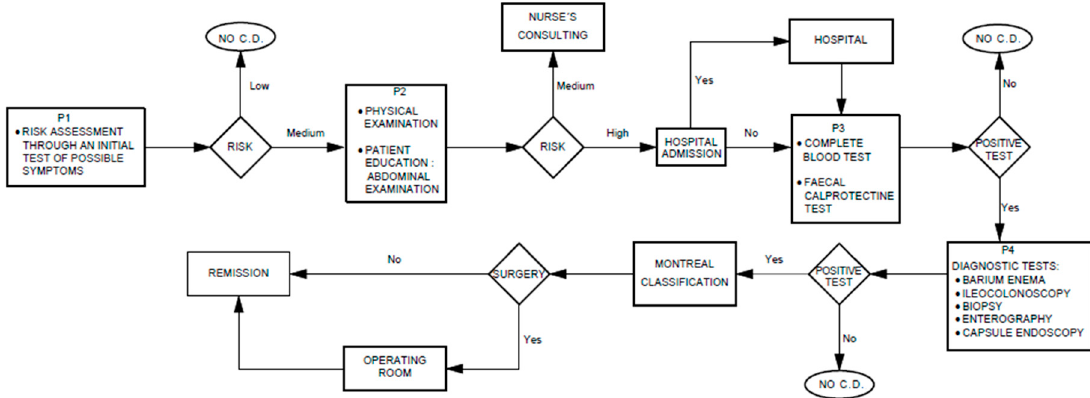
Figure 1. Current diagnosis and treatment Crohn´s disease process.